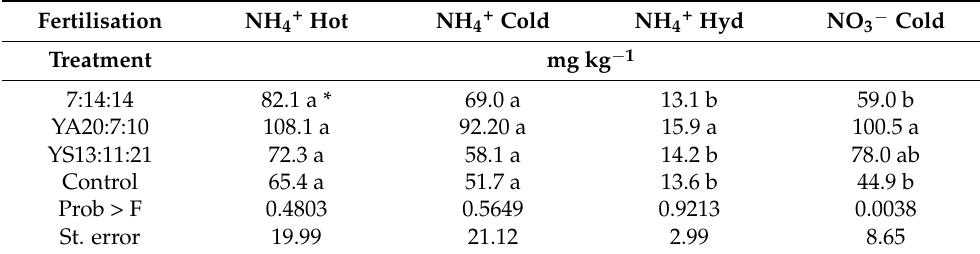
Table 6. Soil ammonium (NH 4+ ) extracted by hot and cold potassium chloride, NH 4+ hydrolysable (Hyd) (NH 4+ hot − NH 4+ cold) and nitrate extracted by cold KCl.